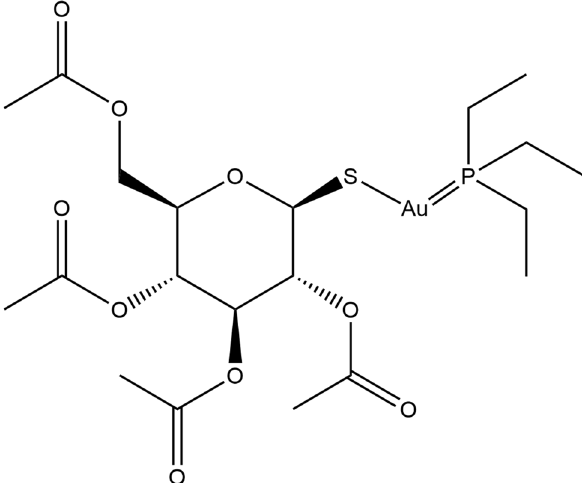
Fig. 1 Structural formula of auranofin. The molecule consists of a monomeric linear complex with trieth- ylphosphine and thiolate moieties bounded to an Au (I) center [10]. The molecule was adapted from the structure published in the CheBI data- base [11] using ChemDraw